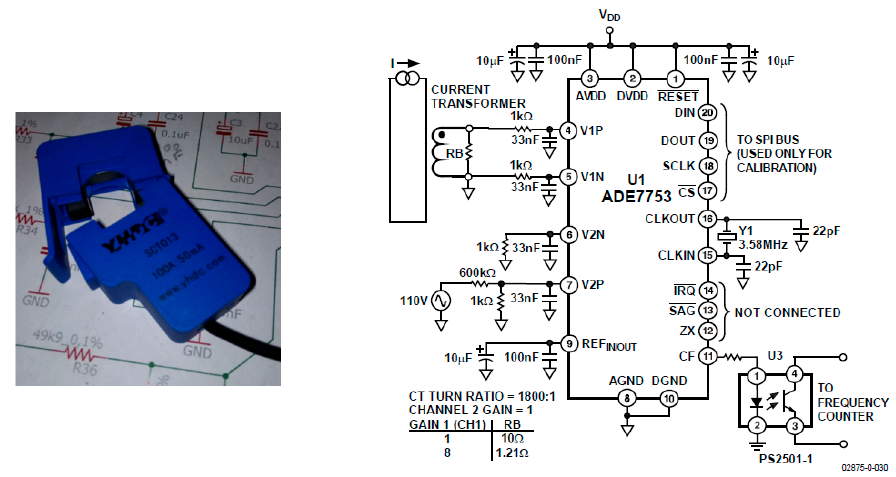
Figure 5. The integrated circuit ADE7753 measures the AC electrical parameters, and the sensor SCT- 013 is the current transformer.